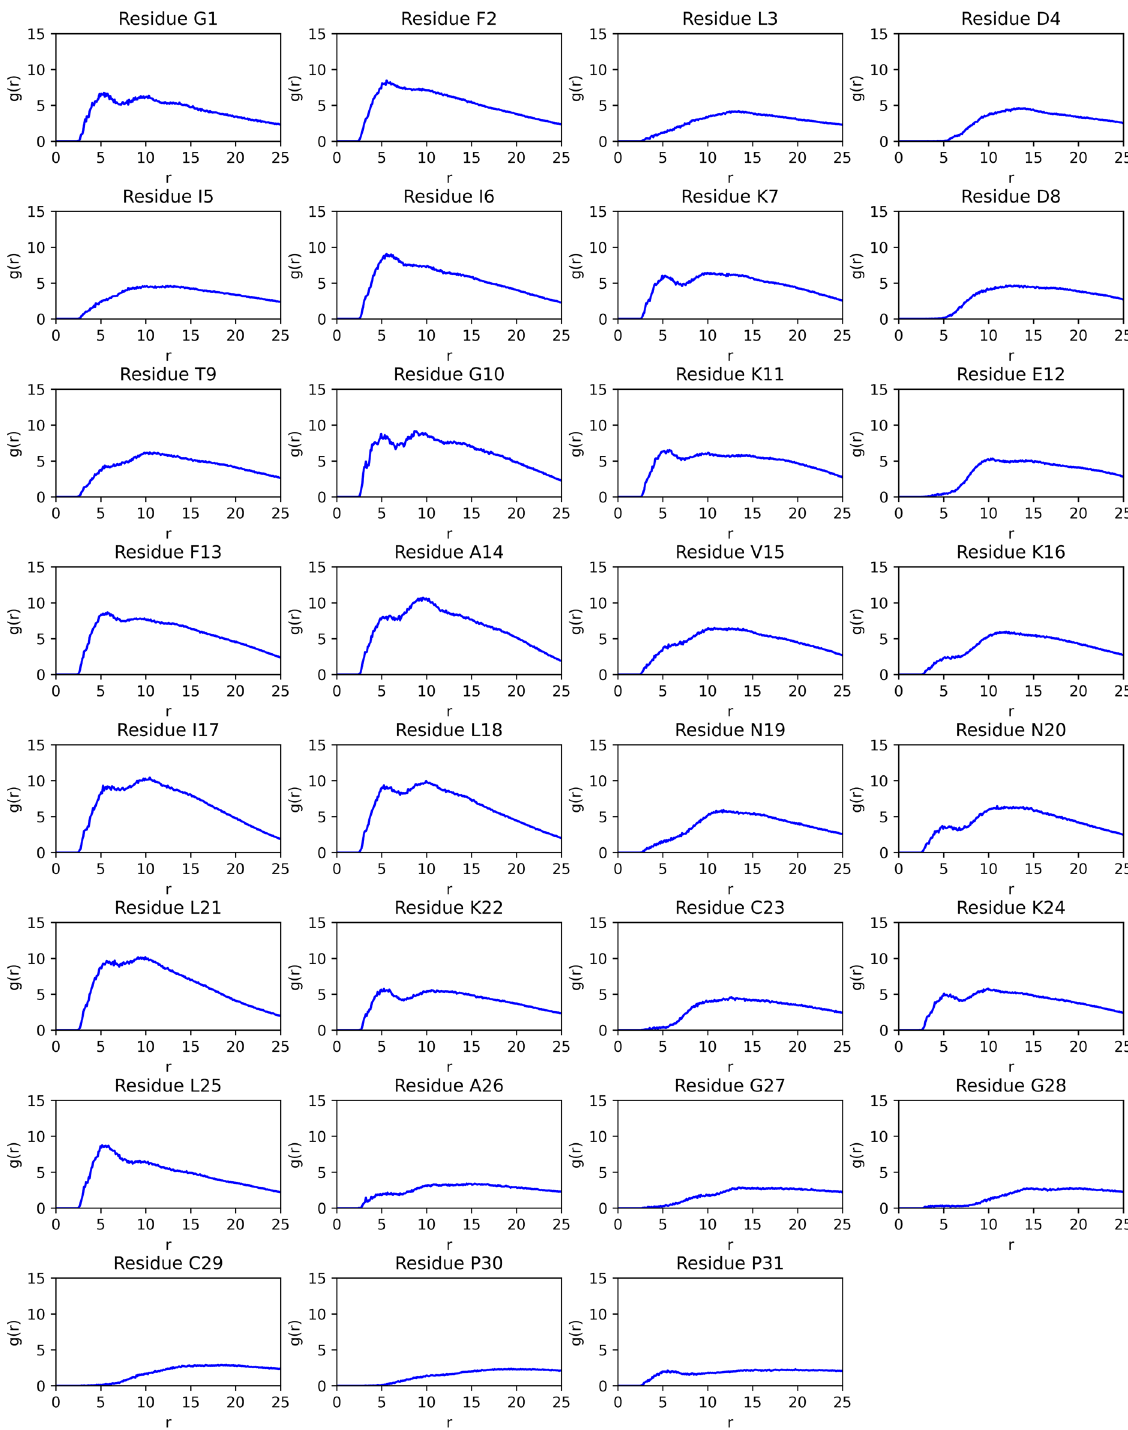
Figure 7. Radial distribution function (RDF) g(r) plotted between palustrin-Ca’s residues’ carbon atoms and the sodium dodecyl sulfate (SDS) micelle aliphatic